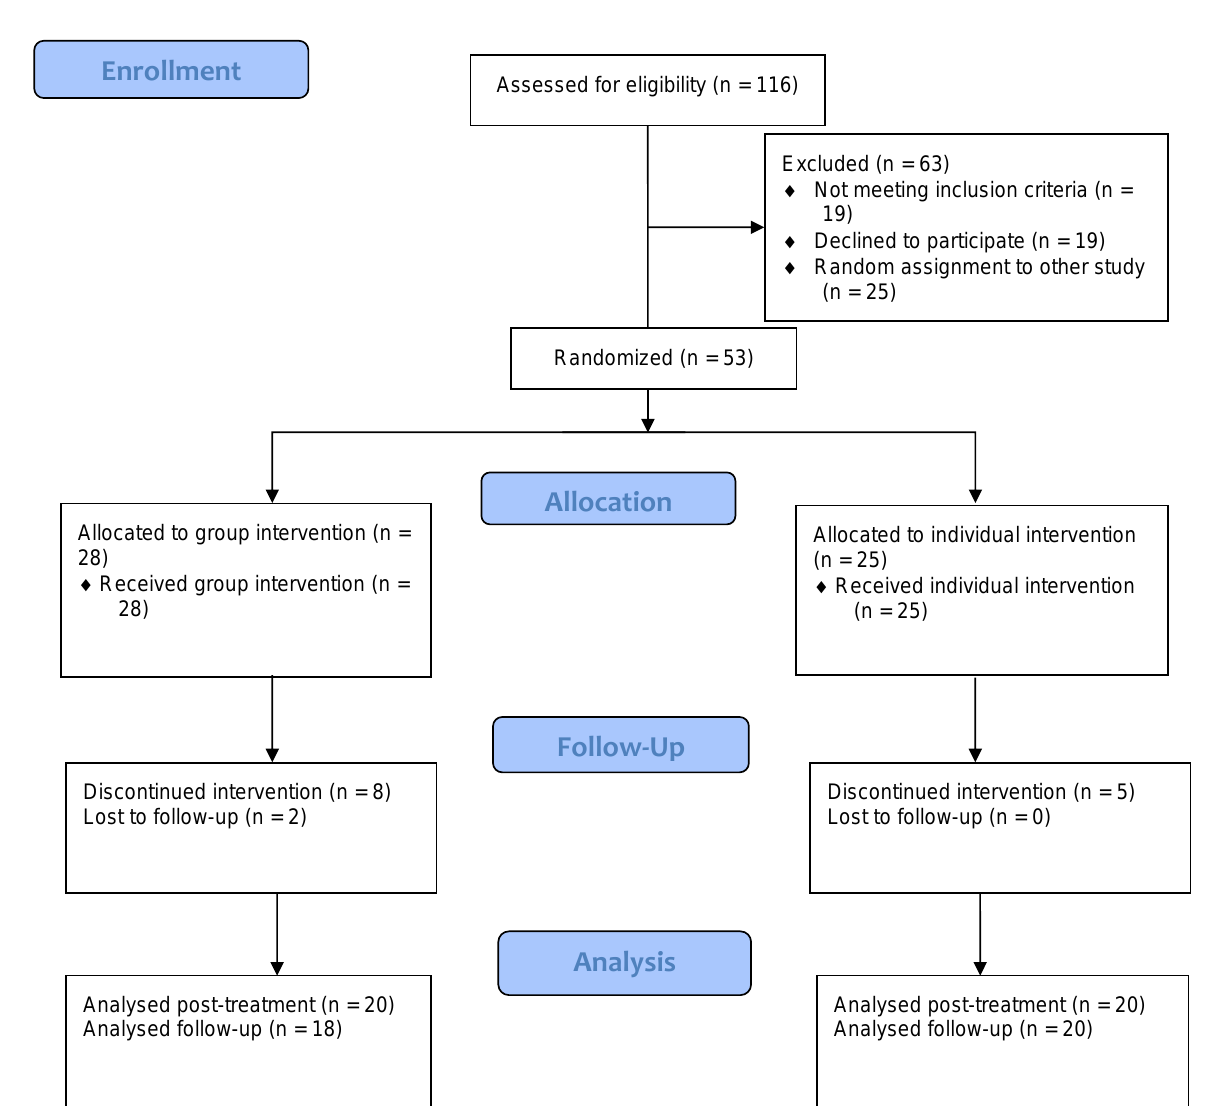
Figure 1. CONSORT participants flow